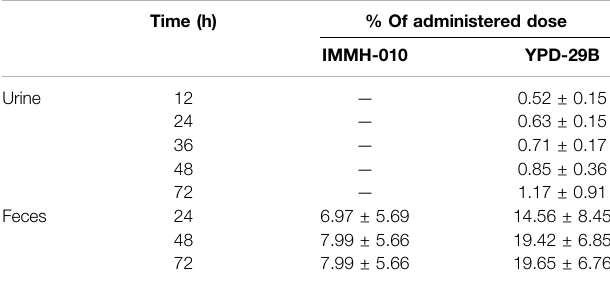
TABLE 9 | The excretion of IMMH-010 and YPD-29B from urine and feces after i.g. administration of IMMH-010 maleate (10 mg/kg) ( n (cid:1)